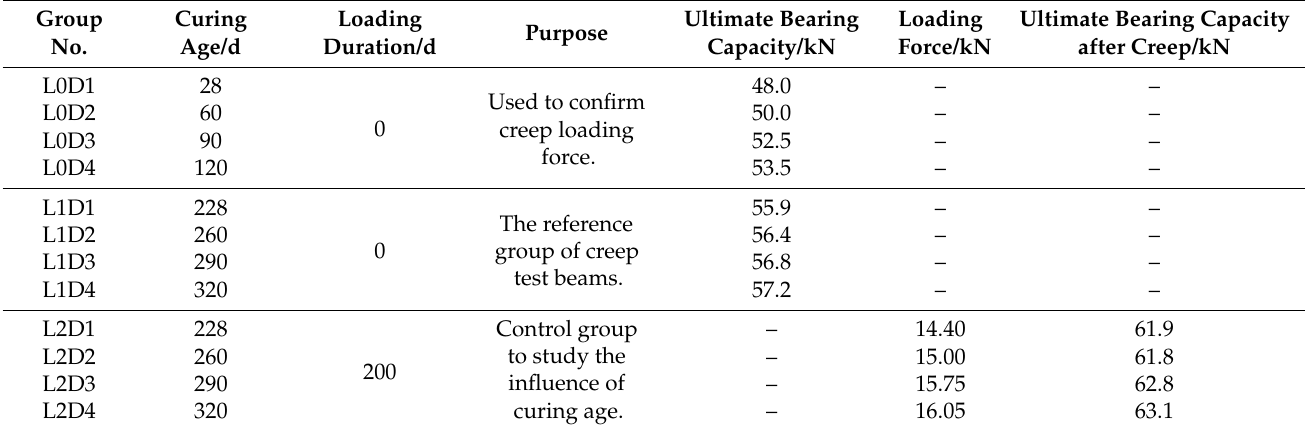
Table 7. Loading parameters of test beam.